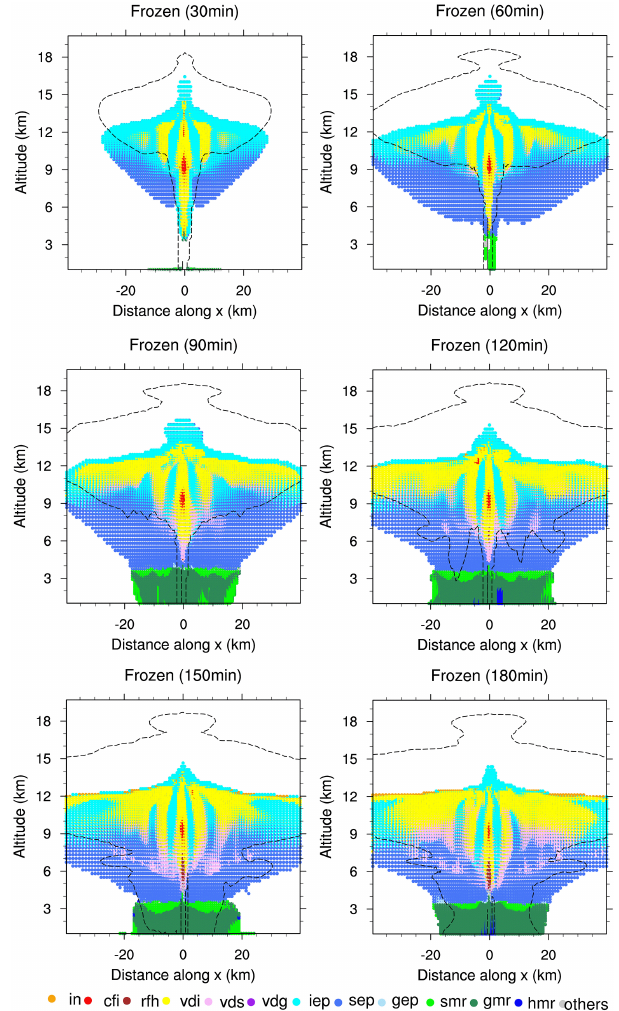
Figure 21. Same as Fig. 17 but for frozen particles.